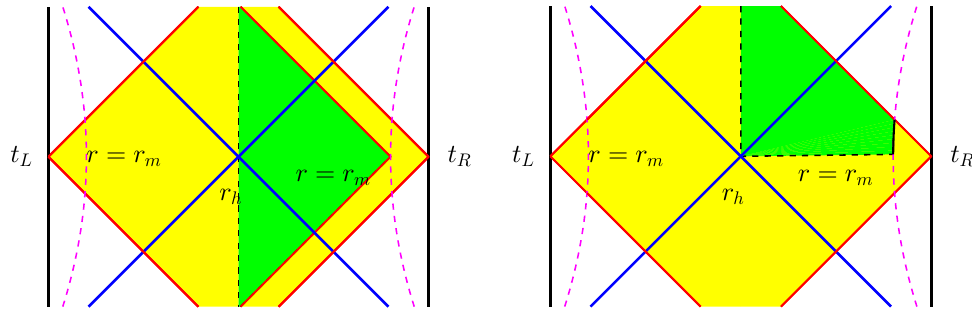
Figure 2 . Two di(cid:11)erent approaches in computing the action at the (cid:12)nite cut-o(cid:11) boundaries. Left panel: the null boundaries of the WDW patch are changed into the null sheets coming from the (cid:12)nite cut-o(cid:11) boundary and there is a null-null joint at the cut-o(cid:11). (here we only show the part near t R . The part near t L is similar.) Right panel: the boundaries of the WDW patch are the same, but, the original null-null joints at the AdS boundary are sliced out by a time like boundary and two null-timelike joints are added. (here we only show the right-top part of quarter. The other parts are